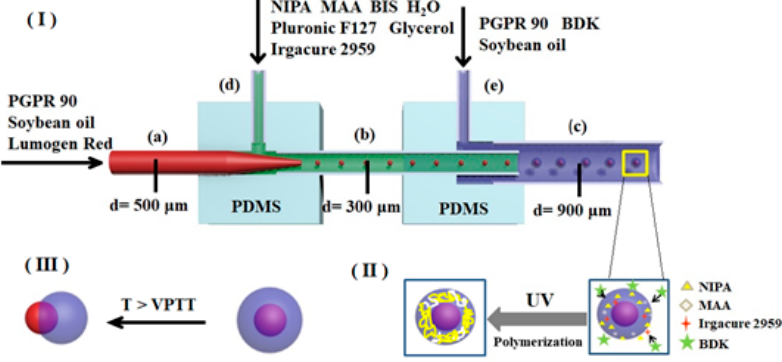
Figure 1. Schematic of P(NIPA- co -MAA) microcapsules fabricated by microfluidic device.